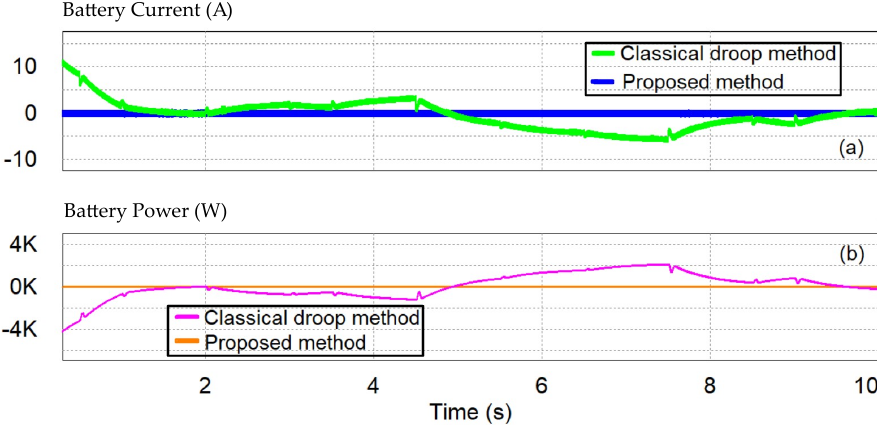
Figure 23. ( a ) The SCES voltage in both methods; ( b ) the SCES power in both methods.